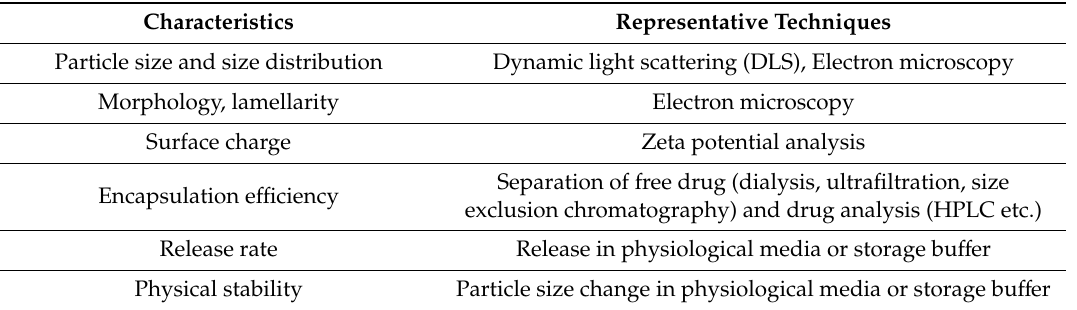
Table 2. Major liposome-specific